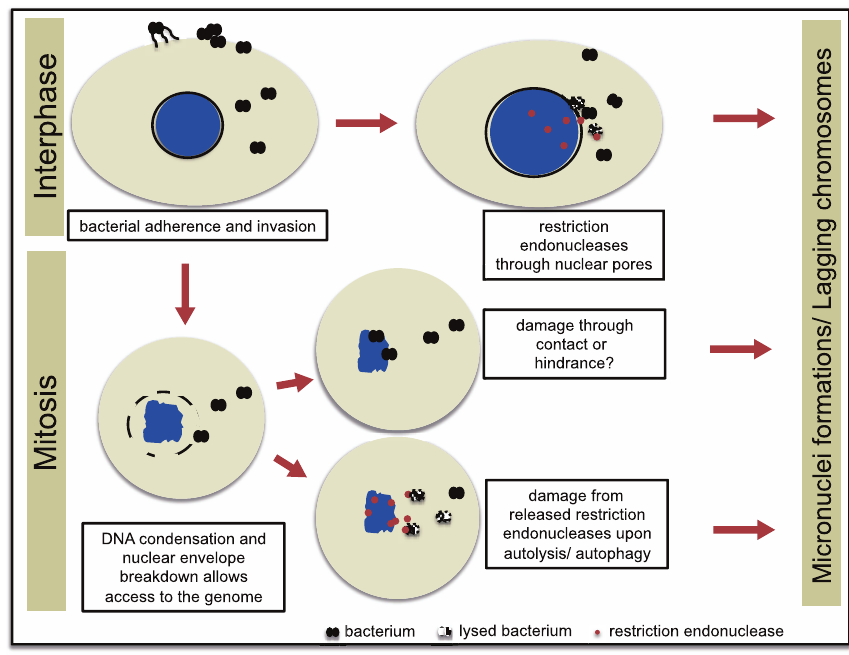
Figure 7. Proposed model of N. gonorrhoeae -induced DNA damage in epithelial cells. N. gonorrhoeae adheres to and invades epithelial cells. Restriction endonucleases are upregulated and released from intact bacterium or through bacterial autolysis during invasion and access the nucleus through nuclear pores during interphase. During early mitosis when the nuclear envelope is broken down, N. gonorrhoeae may interact with the condensed chromatin, which affects mitosis. Bacterial restriction endonucleases released from the bacterium also access the chromatin in mitosis. The result of each scenario is micronuclei formation, ultimately causing damaged DNA in the host